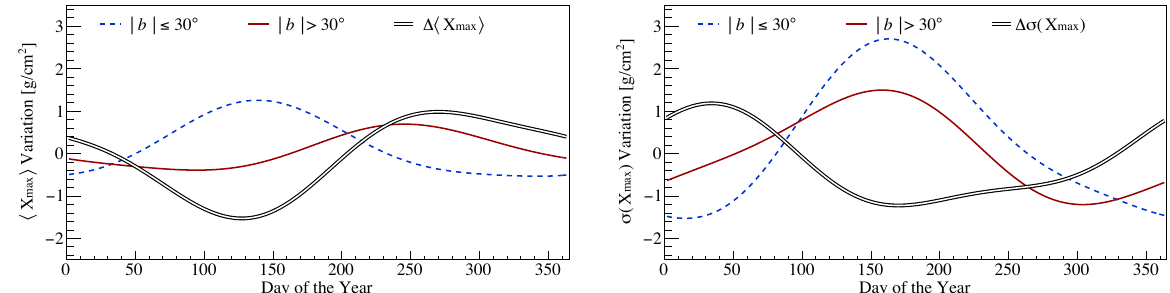
Figure 9: Seasonal fluctuation of the first (left) and second (right) X max moments for the on-plane (blue) and o ↵ -plane (red) samples. The double black line shows the di ↵ erence between these curves. The maximum and minimum values of X 0 these di ↵ erences are taken as the systematic uncertainty on  and   ( X 0 ). max i max h were tracked over the course of the year, and is shown in Figure 9. The maximum exposure-weighted di ↵ erence be- tween the two regions at any point of the year has been adopted as the systematic uncertainty due to seasonal ef- fects. These uncertainties and the total systematic uncer- X 0 tainty on  and   ( X 0 ) are listed in Table 1. max i max h Confidence level considering systematic uncertainties